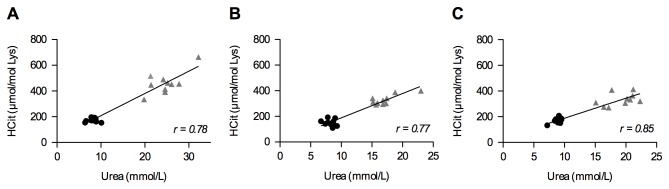
Positive correlation between plasma carbamylated protein and urea.
concentrations after surgery.Plasma carbamylated protein and urea concentrations were correlated 5 (A), 10 (B) and 20 (C) weeks after surgery. The concentration of carbamylated proteins is expressed as the ratio of homocitrulline (μmol) to lysine (mol). Each dot corresponds to one mouse (10 mice per group). Circles represent sham-operated mice, triangles represent nephrectomised mice. A non-parametric Spearman test was used for the calculation of correlation coefficients, p< 0.0001.